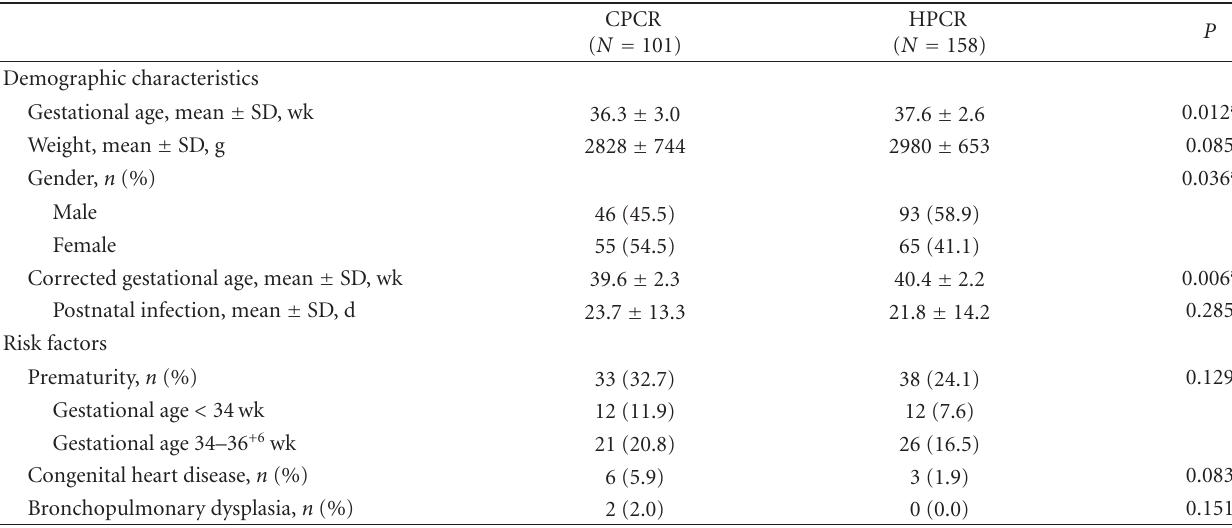
Table 1: Demographic characteristics and risk factors of newborns hospitalized in NICU with an RSV infection presenting a CPCR versus HPCR pattern.